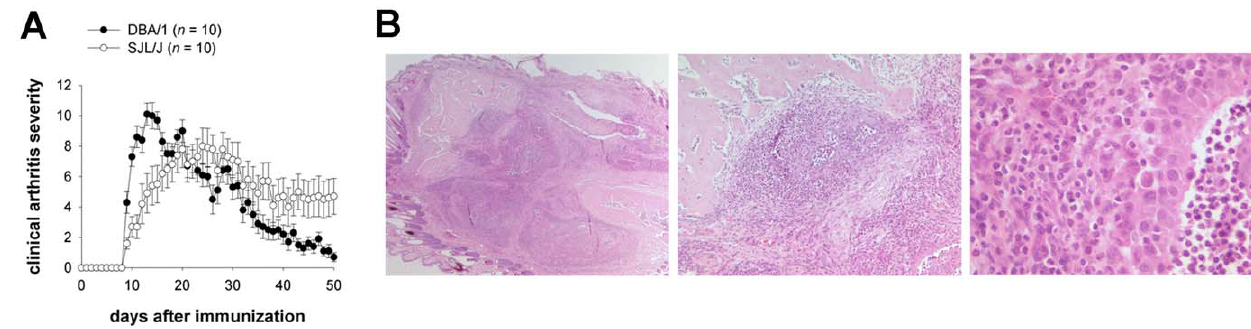
Figure 1. SJL/J mice are susceptible to G6PI-induced arthritis. A) Age matched female DBA/1 and SJL/J mice were immunized with 400 m g G6PI in complete Freund’s adjuvant and scored for clinical arthritis severity as described in Materials and Methods . B) Histological features of G6PI- induced arthritis in SJL/J mice. The overview (left, 6 25) shows the severe destruction of the joint. Cartilage is completely missing, and parts of the underlying bone are infiltrated as well (center, 6 100). The inflammatory infiltrate consist mainly of neutrophil granulocytes, but lymphocytes and plasma cells are clearly visible (right, 6 400). The underlying pannus consists of activated fibroblasts and is covered by an enlarged synovial lining. In the synovial space, a putrid exudate with numerous granulocytes is found (all figures, H&E staining).